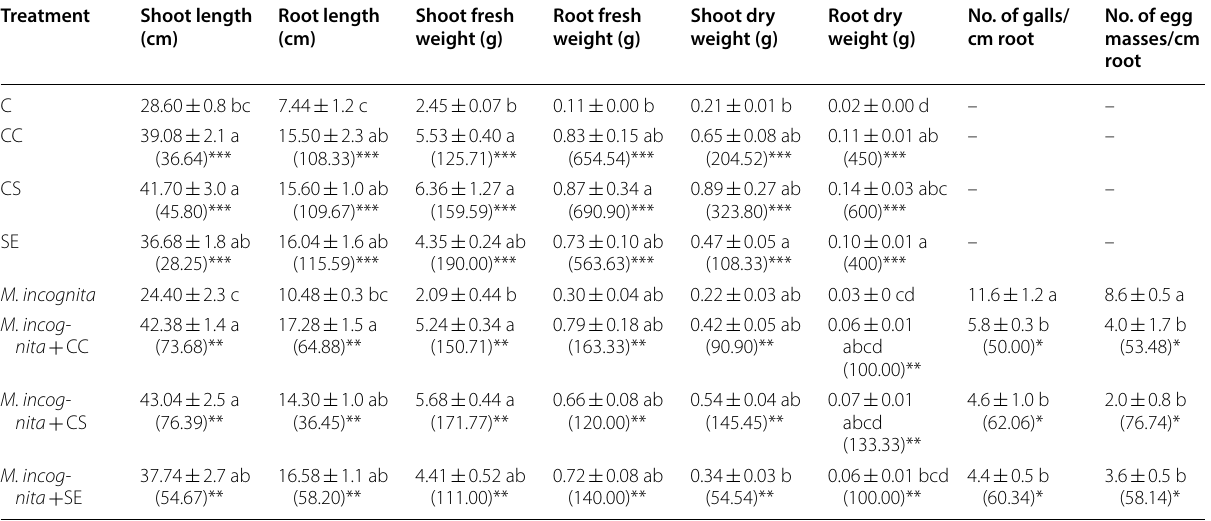
Table 1 Effect of S. antibioticus strain M7 on various growth traits of tomato seedlings infested with M. incognita